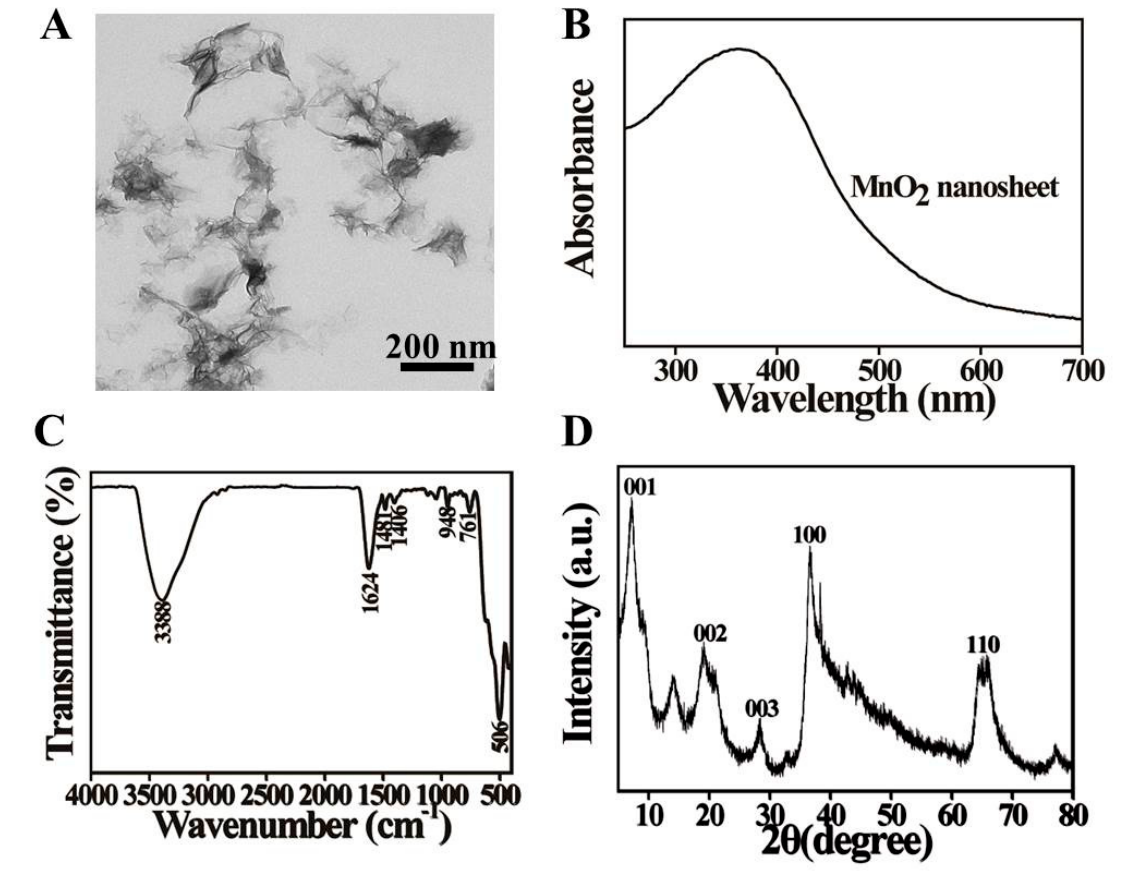
Figure 1. ( A ) Transmission electron microscopy (TEM) image, ( B ) UV-vis spectrum, ( C ) Fourier transform infrared (FTIR) spectra and ( D ) X-ray di ff raction (XRD) patterns of MnO 2